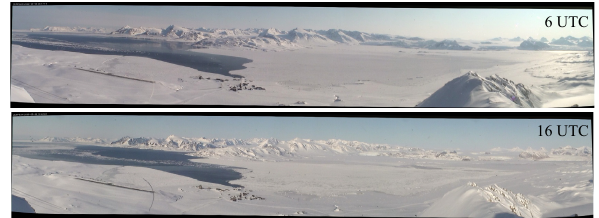
Figure 3. Webcam view from Zeppelin mountain on 8 May 2009, 06:00 and 16:00UTC. More drift ice is visible in the western outer part of the Fjord in the morning. High clouds appear faintly on the northwestern horizon. Note the changing brightness of the snow on the frozen Fjord relative to the snow covered